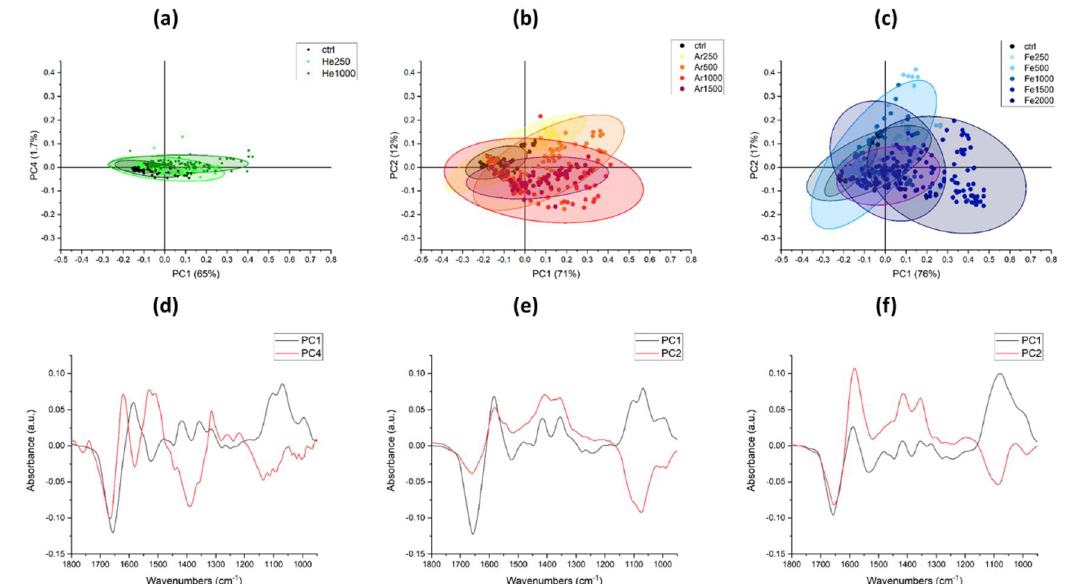
Figure 7. Principal components analysis (PCA) of P. thermantarcticus’ spores’ spectra. ( a ) Scatterplot showing that, in the PC1-PC4 planes, the PCA scores of the data were acquired on the spores irradiated with He. ( b ) Scatterplot showing that, in the PC1-PC2 planes, the PCA scores of the data were acquired on the spores irradiated with Ar. ( c ) Scatterplot showing that, in the PC1-PC2 planes, the PCA scores of the data were acquired on the spores irradiated with Fe. Ellipses represent the 95% confidence value. In parenthesis, in the axis name, the percentage of variance is shown, represented by each PC ( d – f ), with loading vectors representing the principal components shown in panels ( a – c ) in the spectral range from 1800 to 950 cm −1 .